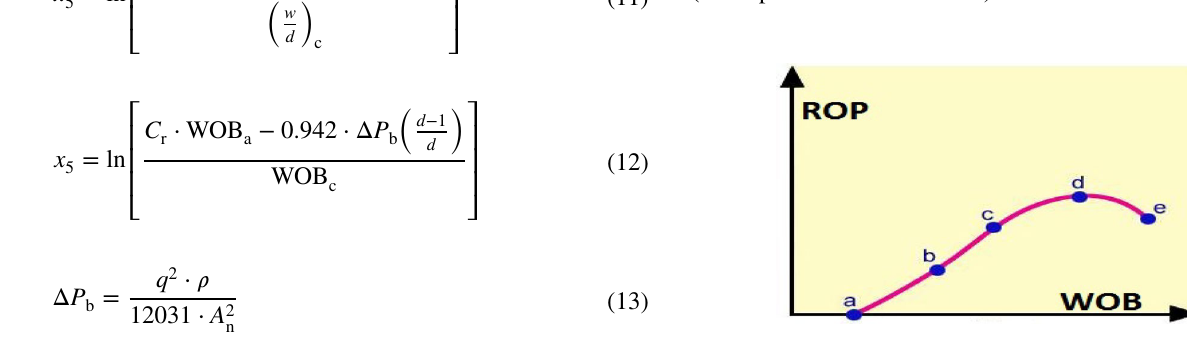
Fig. 5 Weight on bit and rate of penetration relationship (Ahmed et al.